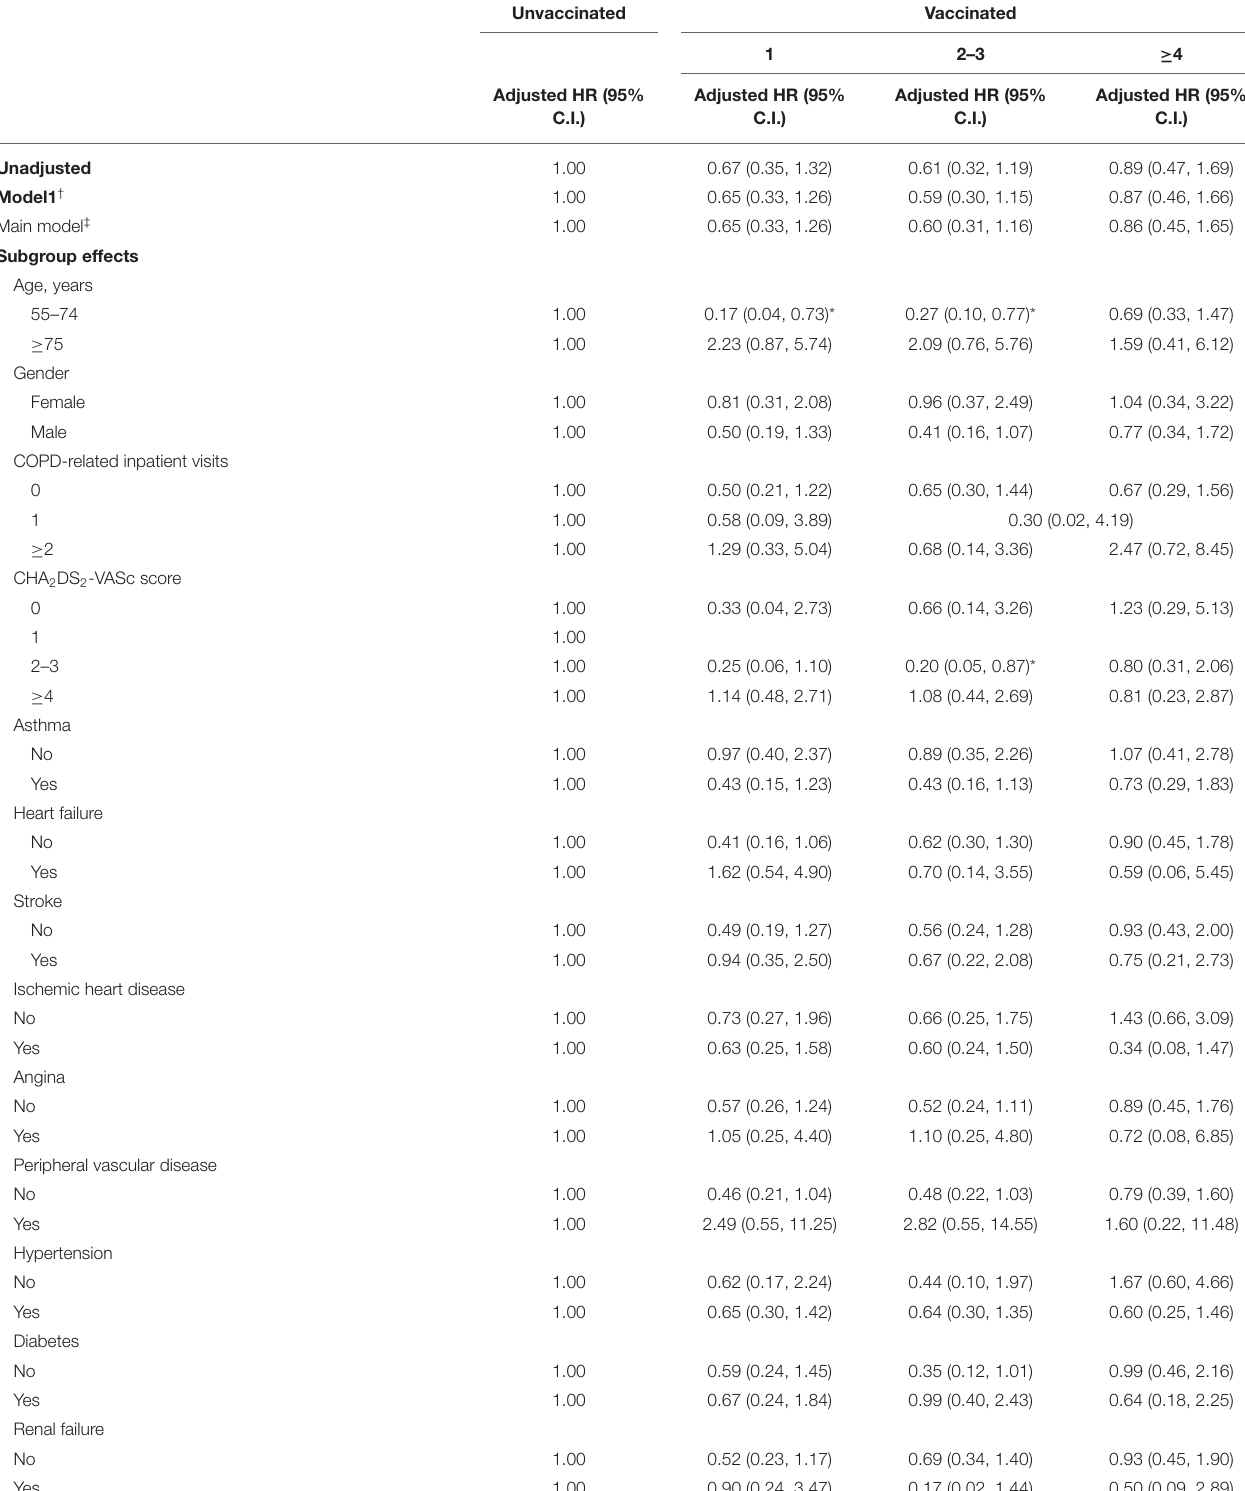
TABLE 4 | Sensitivity analysis of adjusted HRs of vaccination in risk reduction of ventricular arrhythmia in non-influenza